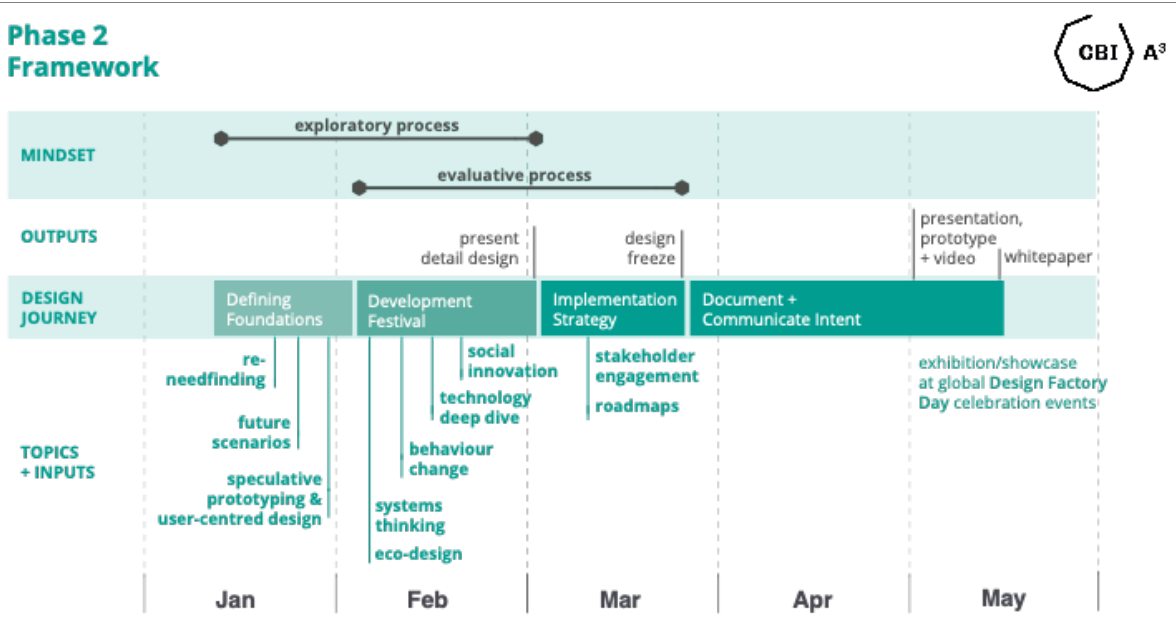
Fig. 3. Phase 2 Framework of CBI A 3 Program.